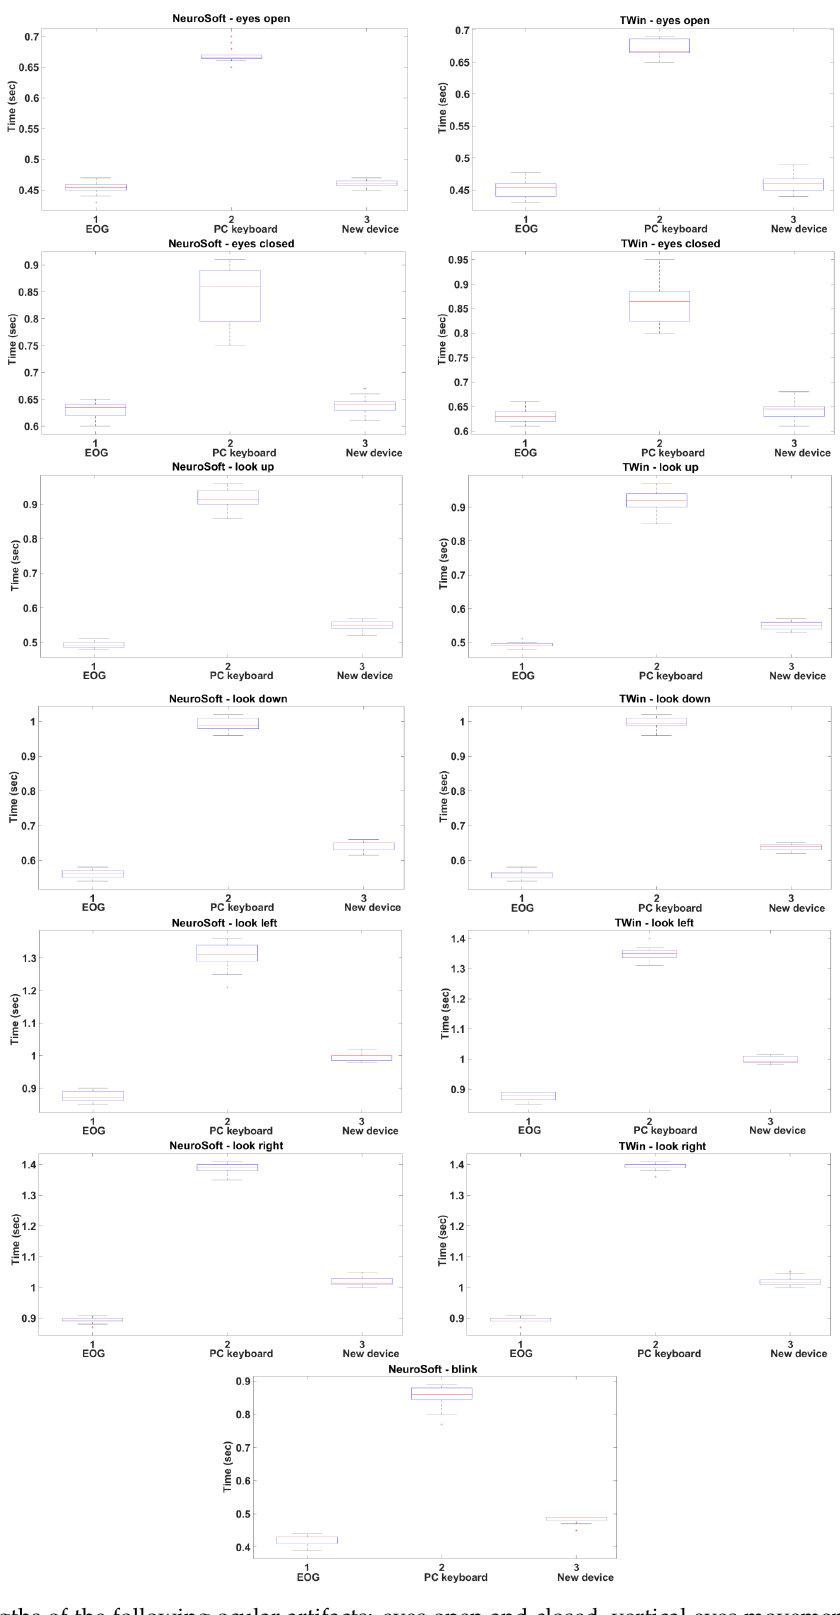
Figure 4. The lengths of the following ocular artifacts: eyes open and closed, vertical eyes movements (up and down), horizontal eyes movements (left, right), and blink, marked using the PC keyboard, the new device, and EOG channels. Within the box, a vertical red line means the median value of the data set, whereas the bottom and top blue line of the box indicate the 25th and 75th percentiles, respectively; the whiskers present min and max and the outliers are marked with the ‘ + ’ symbol.